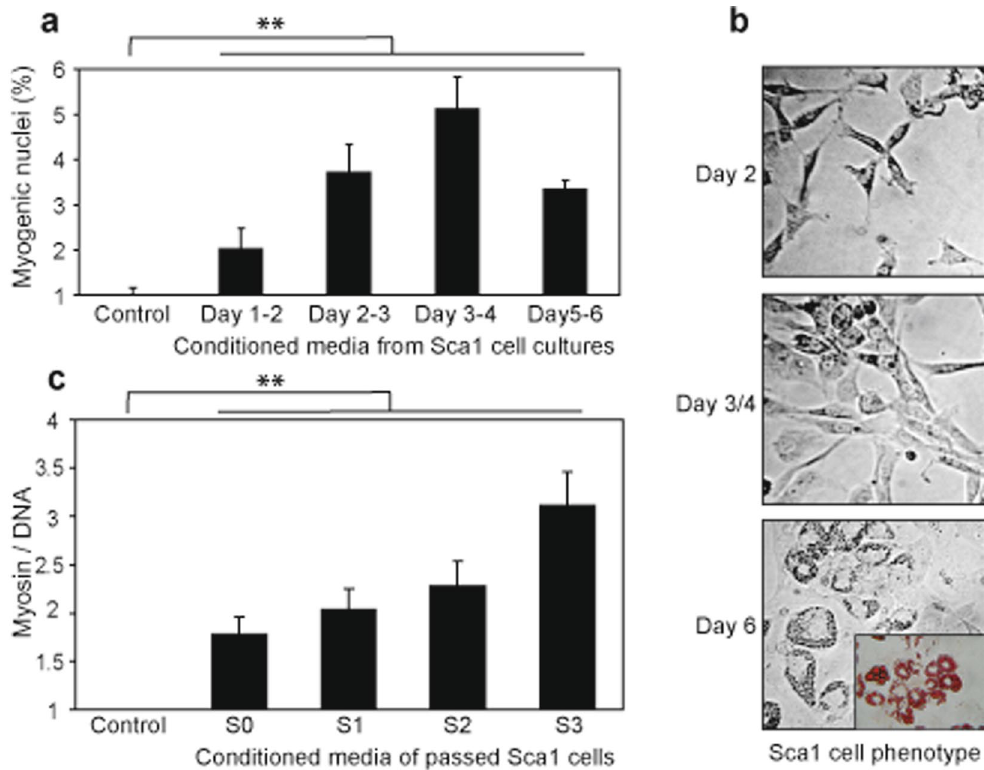
Figure 2. Proliferative pre-adipocytes produce myogenic factors. ( a ) Conditioned media prepared from CD34 + /Sca1 + primary cell cultures enhanced myogenic differentiation of initial fraction cells. Conditioned media were prepared from 24 h of CD34 + /Sca1 + cell cultures between day 1–2 (Day 1–2), day 2–3 (Day 2–3), day 3–4 (Day 3–4) and day 5–6 (Day 5–6), respectively. The percentage of myogenic nuclei was assessed microscopically on initial fraction cells cultured in conditioned media for 4 days, using cells in